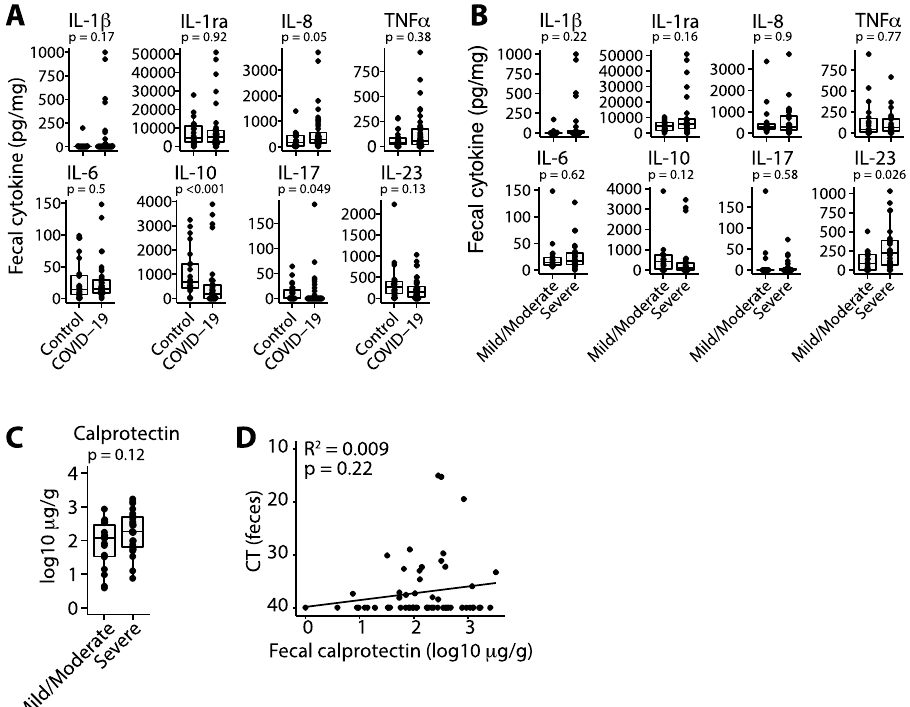
Figure 3. Fecal cytokine levels in COVID-19 patients. ( A ) Concentrations of cytokines in fecal samples from control donors and COVID-19 patients. Where multiple samples from the same donor were collected, the median of these samples is plotted. ( B ) Concentrations of fecal cytokines in COVID-19 patients with severe disease compared to those with non-severe disease. ( C ) Concentrations of fecal calprotectin in COVID-19 patients with severe disease compared to those with non-severe disease. ( D ) Concentrations of fecal calprotectin are unrelated to fecal viral load. Boxplots show median + / − IQR and p values are calculated by Mann–Whitney